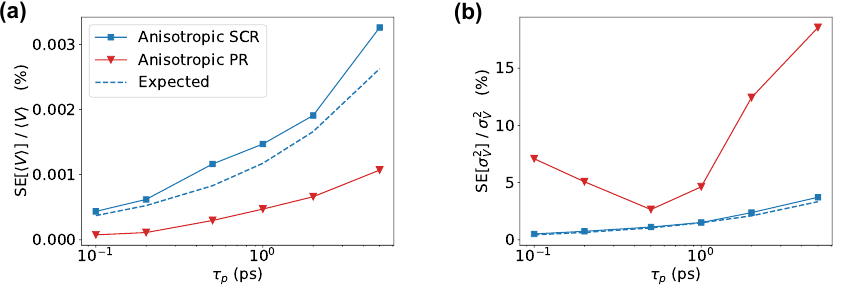
Figure 5. Relative errors on the estimates of volume average—panel ( a )—and volume variance— panel ( b )—from the simulations of the Lennard-Jones crystal using GROMACS. Different values of τ P were scanned between 0.1 ps and 5 ps.